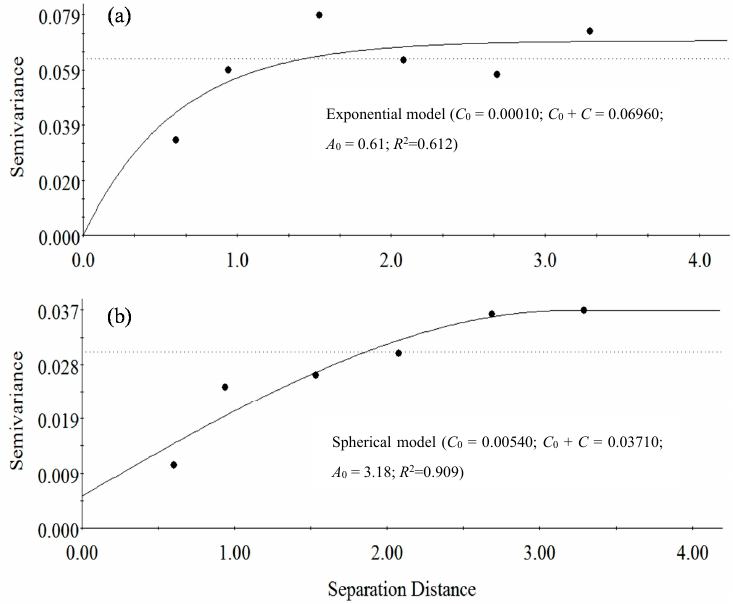
Exponential model ( C 0 = 0.00010; C 0 + C = 0.06960; A 0 = 0.61; R 2 =0.612)